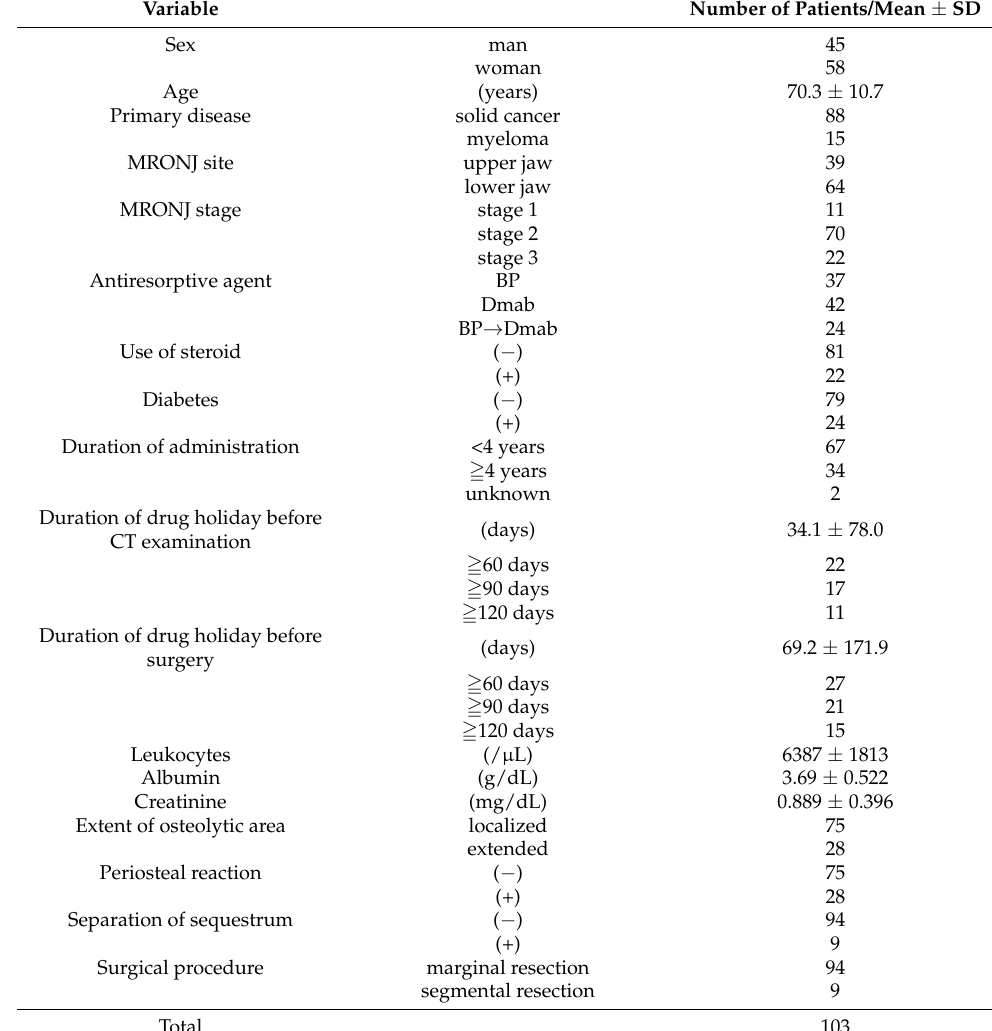
Table 1. Patient